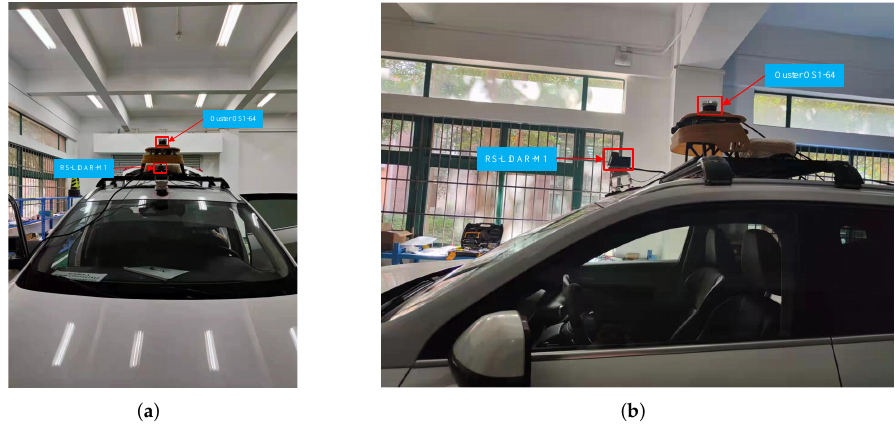
Figure 12. Experimental platform. ( a ) Front view. ( b ) Side view. Ouster OS1-64 and RS-LiDAR-M1 were placed on the roof and front of the vehicle,